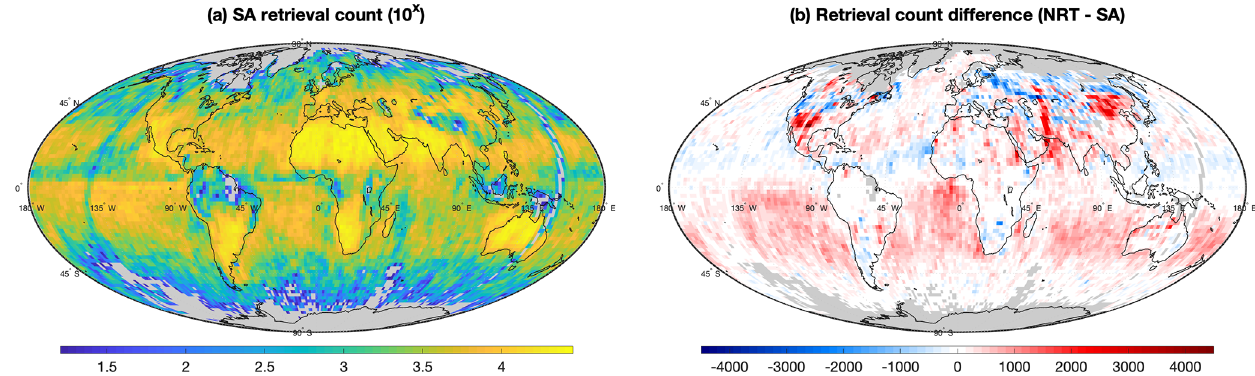
Figure 8. (a) Decimal logarithm of the retrieval count from the SA product in March, April, and May of 2020. (b) Retrieval count difference between NRT and SA. Presented values are gridded at 2 ◦ × 2 ◦ spatial resolution and grid points with less than 15 retrievals are excluded.